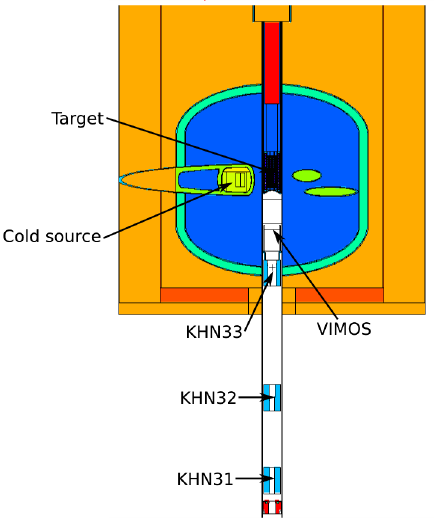
FIG. 2. MCNPX model of the SINQ with the collimators. Vertical cut through the D 2 O tank and the three water cooled